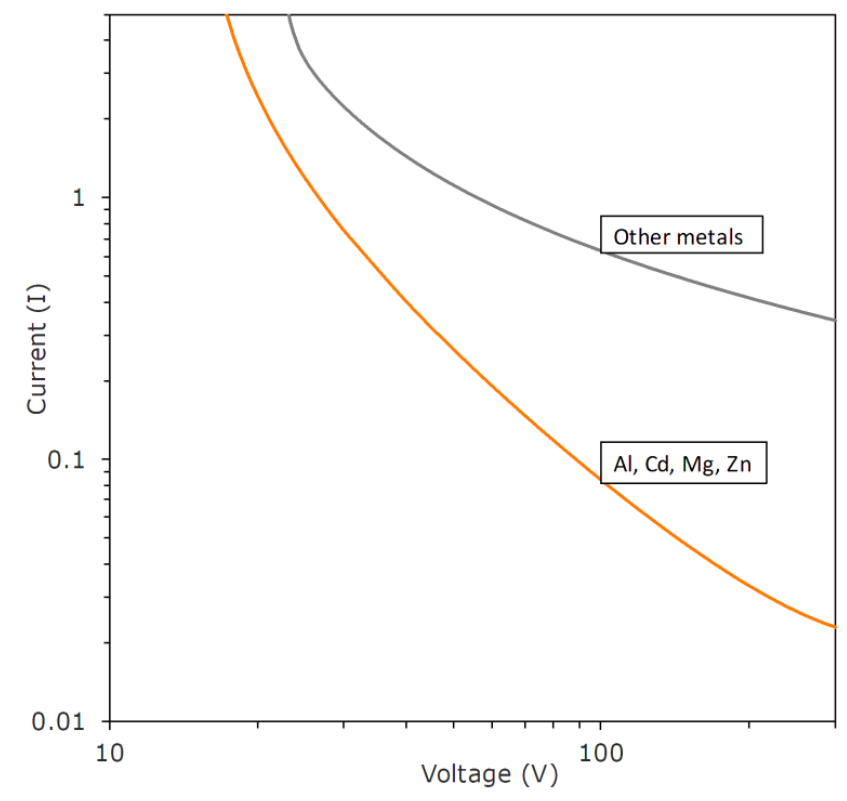
Figure 4. Ignition curves for methane gas atmospheres in resistive circuits published by SMRE; curves give MIC as a function of voltage.